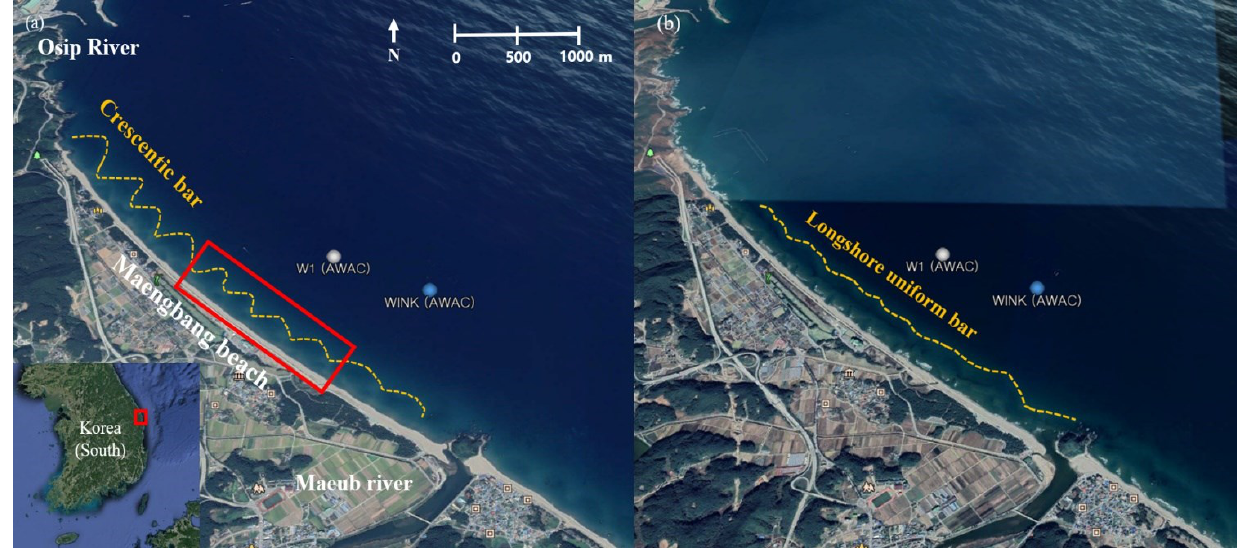
Figure 1. ( a ) Maengbang beach with crescentic bars; and ( b ) longshore uniform bar due to a series of storms (image acquired from Google Earth). The area within the red rectangle denotes the location where analysis of bathymetric data and numerical results is performed.